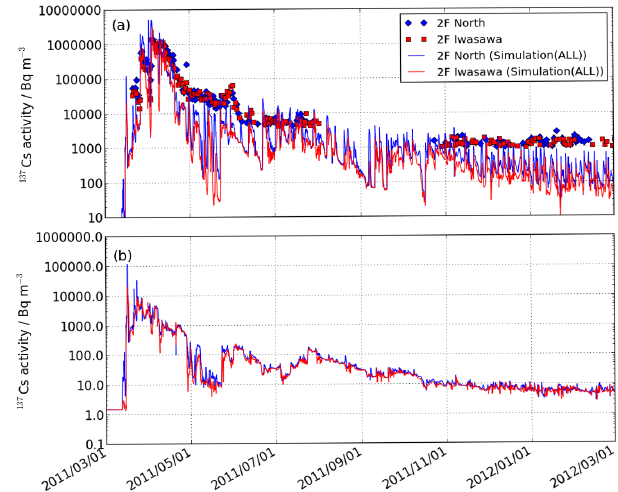
Fig. 6. (a) Measured 137 Cs activities (Bqm − 3 ) at the 2F NPP north discharge canal (10km south of the 1F NPP site) and offshore of Iwasawa (16km south of the 1F NPP site) and simulated 137 Cs activities (ALL scenario). (b) Difference of activities between the ALL and D RELEASE